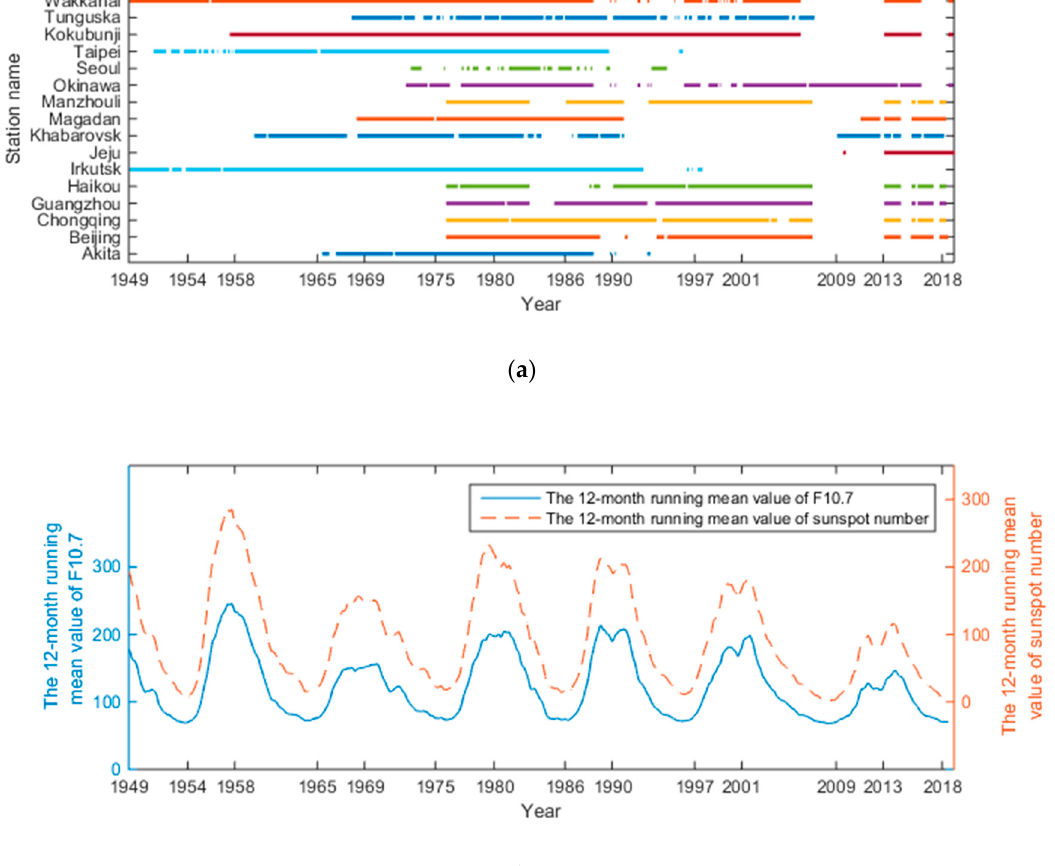
Figure 3. The time of data collected from ionosonde station and the corresponding cycle variations of solar activity factor ( F 12 and R 12 ). ( a ) The time of data collected from ionosonde station; ( b ) the cycle variations of solar activity factor corresponding to the collected data.